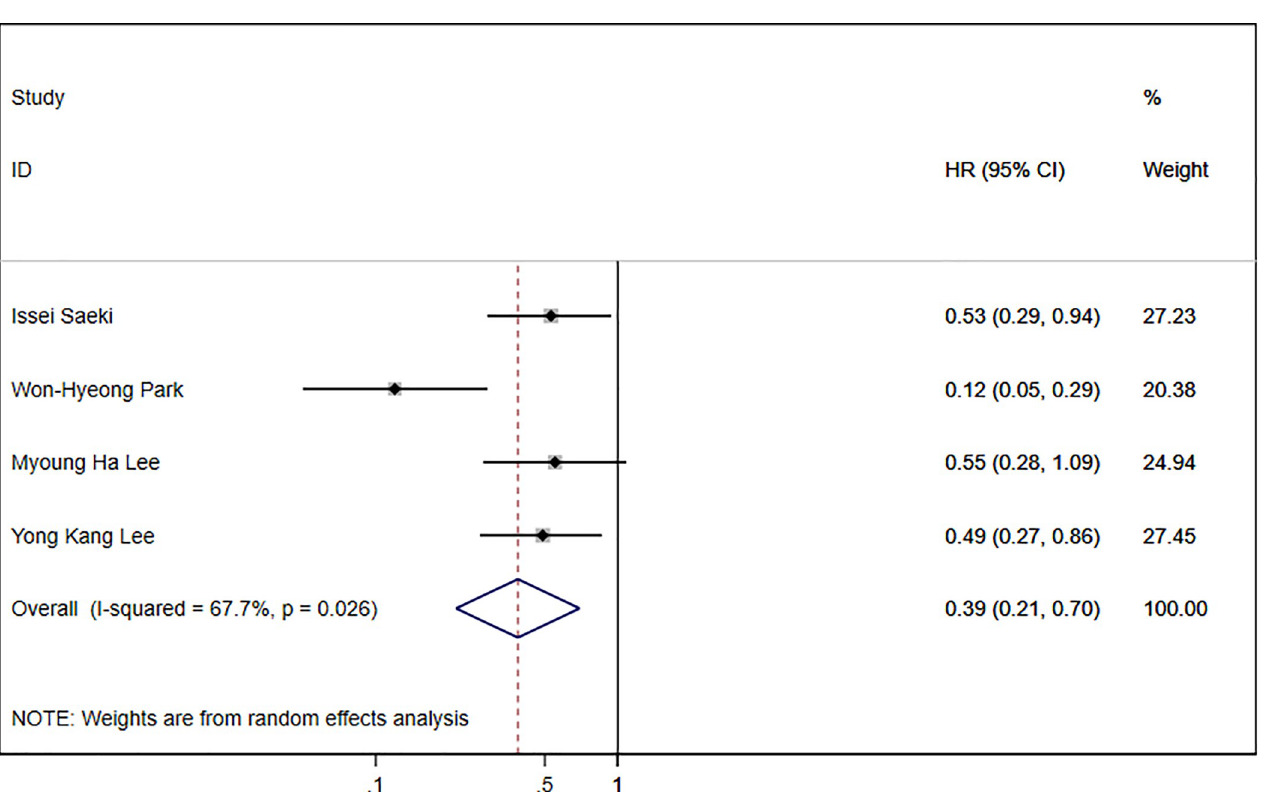
Fig 4. Forest plot of four studies with HR of DCP response for